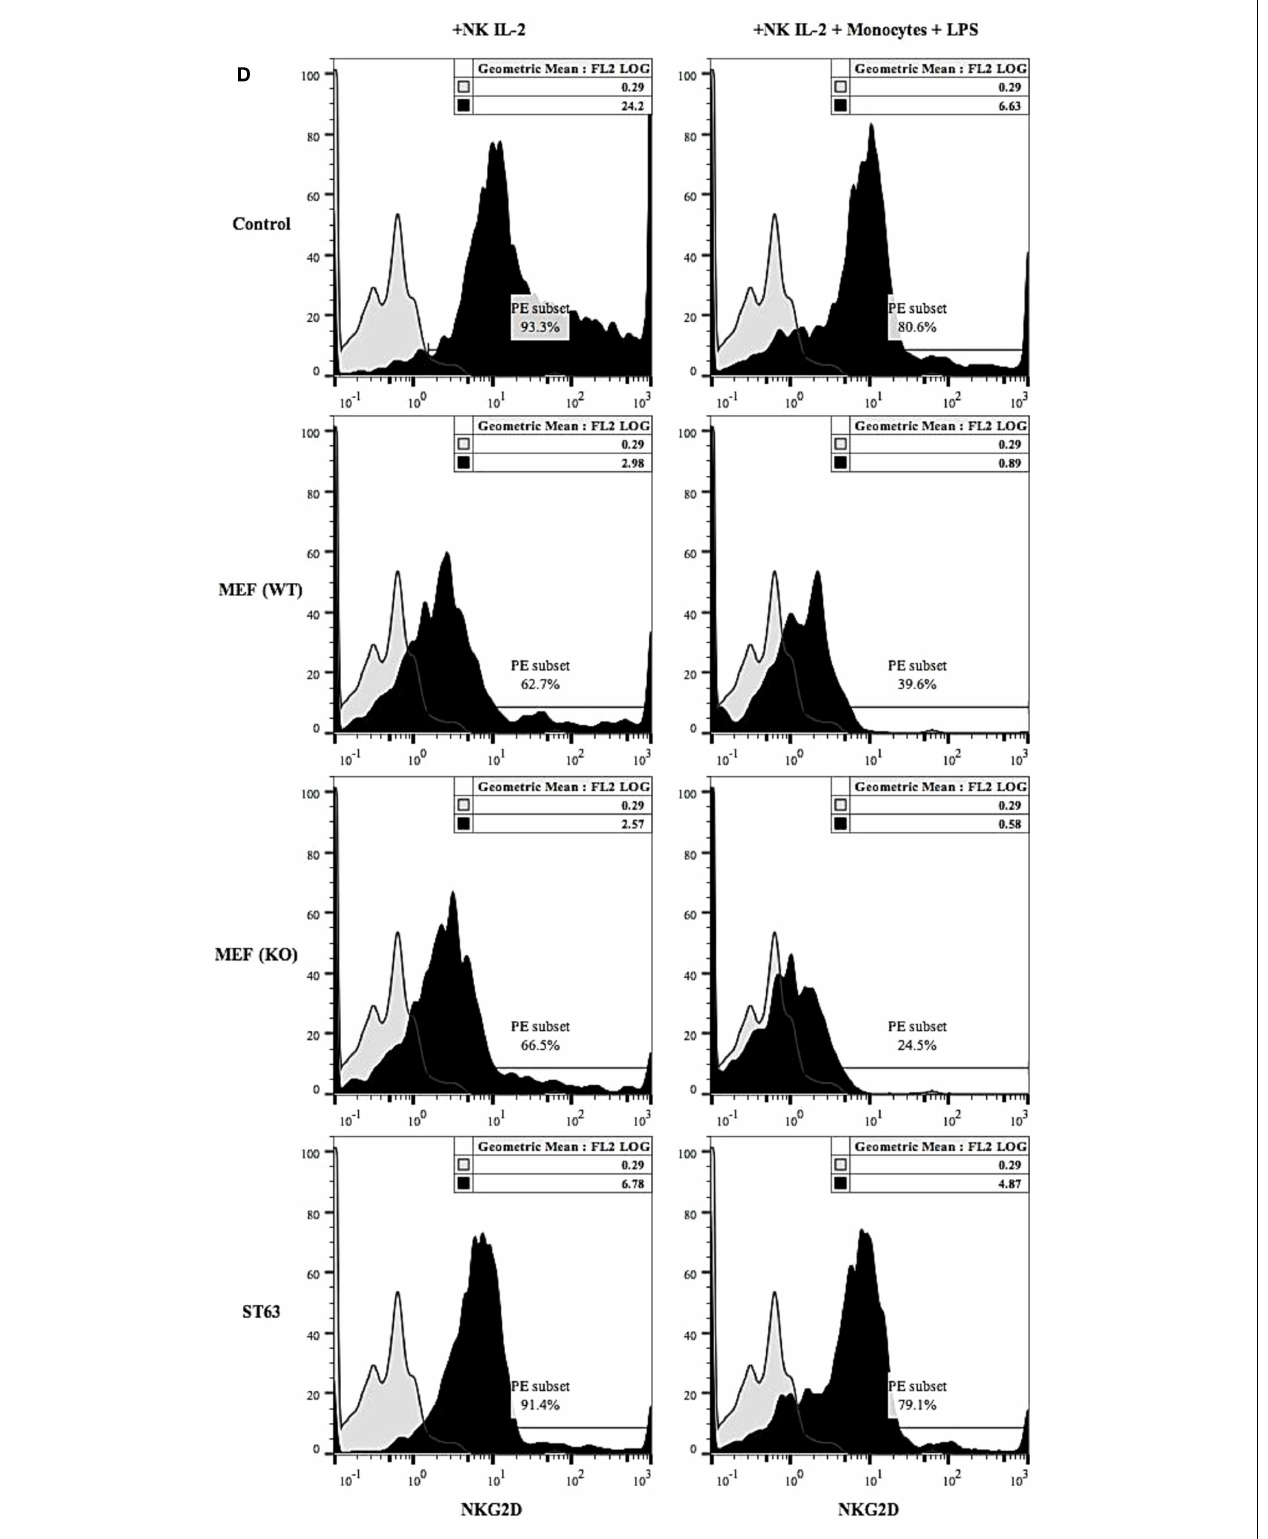
ST63 at 9:1 (NK cells: target ratio) for 48h. Thereafter, the surface expression of DX5 (A) , Ly49A (B) , Ly49D (C) and NKG2D (D) were assessed using staining with PE-conjugated antibodies followed by flow cytometric analysis. Isotype control antibody was used as control. One of three experiments is shown.